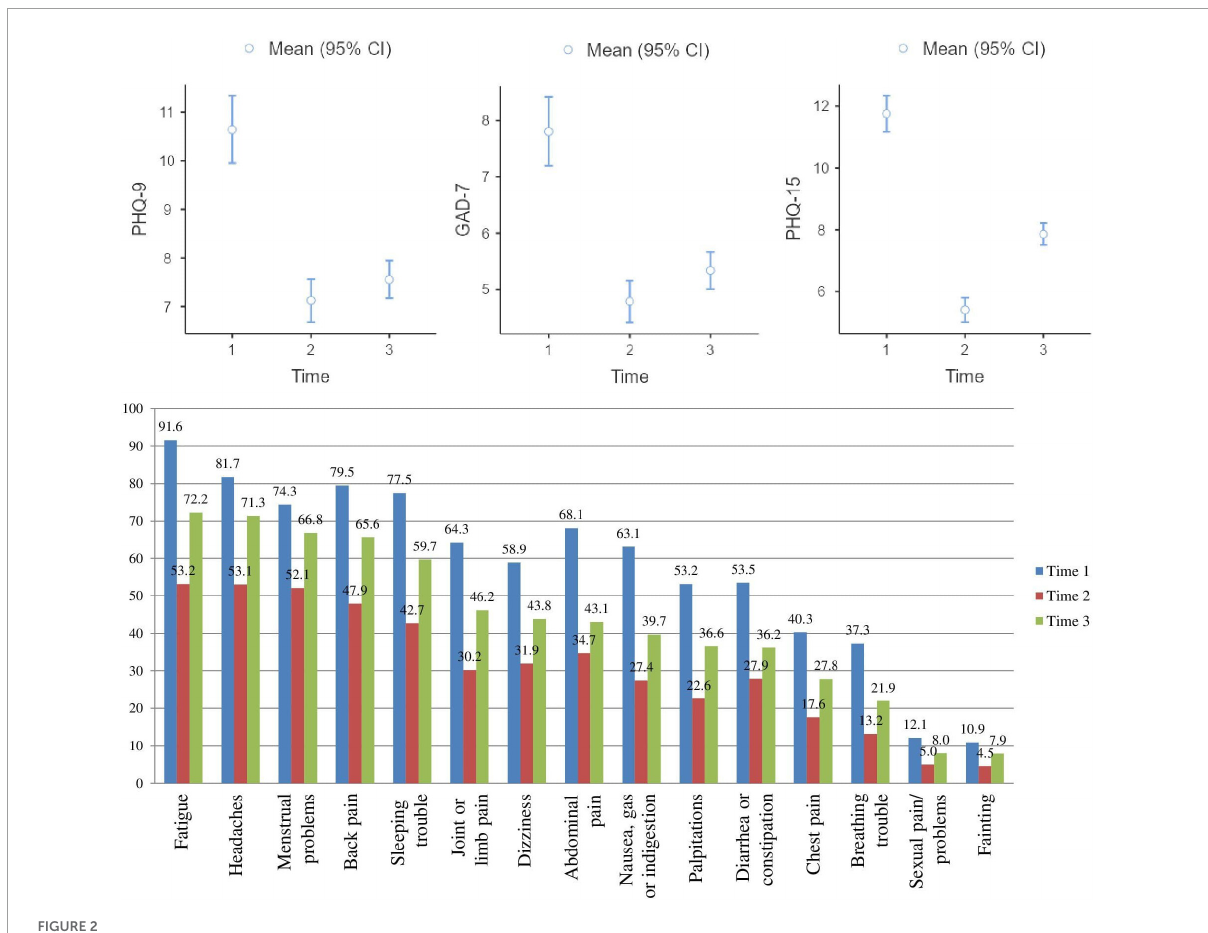
FIGURE2 Average values in PHQ-9, GAD-7, and PHQ-15 scale, and prevalence of somatic symptoms in Time 1, 2, and 3.